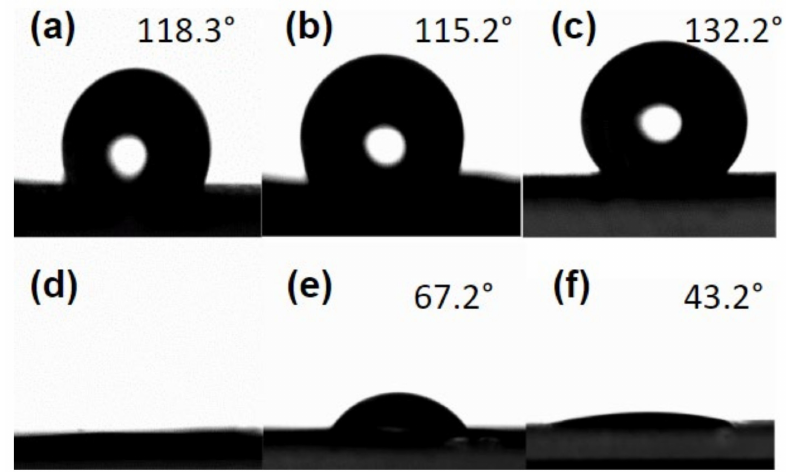
Figure 6. Water contact angle for electrospun samples with morphological variations. ( a ) PCL fibres; ( b ) PCL beaded fibres; ( c ) PCL beads; ( d ) PCL + Prop fibre; ( e ) PCL + Prop beaded fibres; ( f ) PCL + Prop